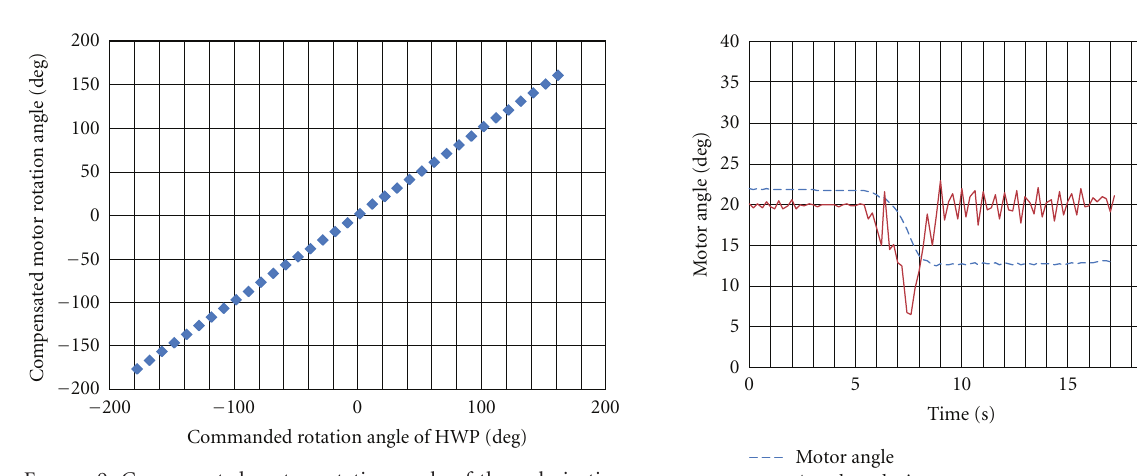
Figure 9: Compensated motor rotation angle of the polarization tracking system in the receiver as a function of commanded rotation angle of the half-wave plate in the polarization rotating simulator in front of the receiver.